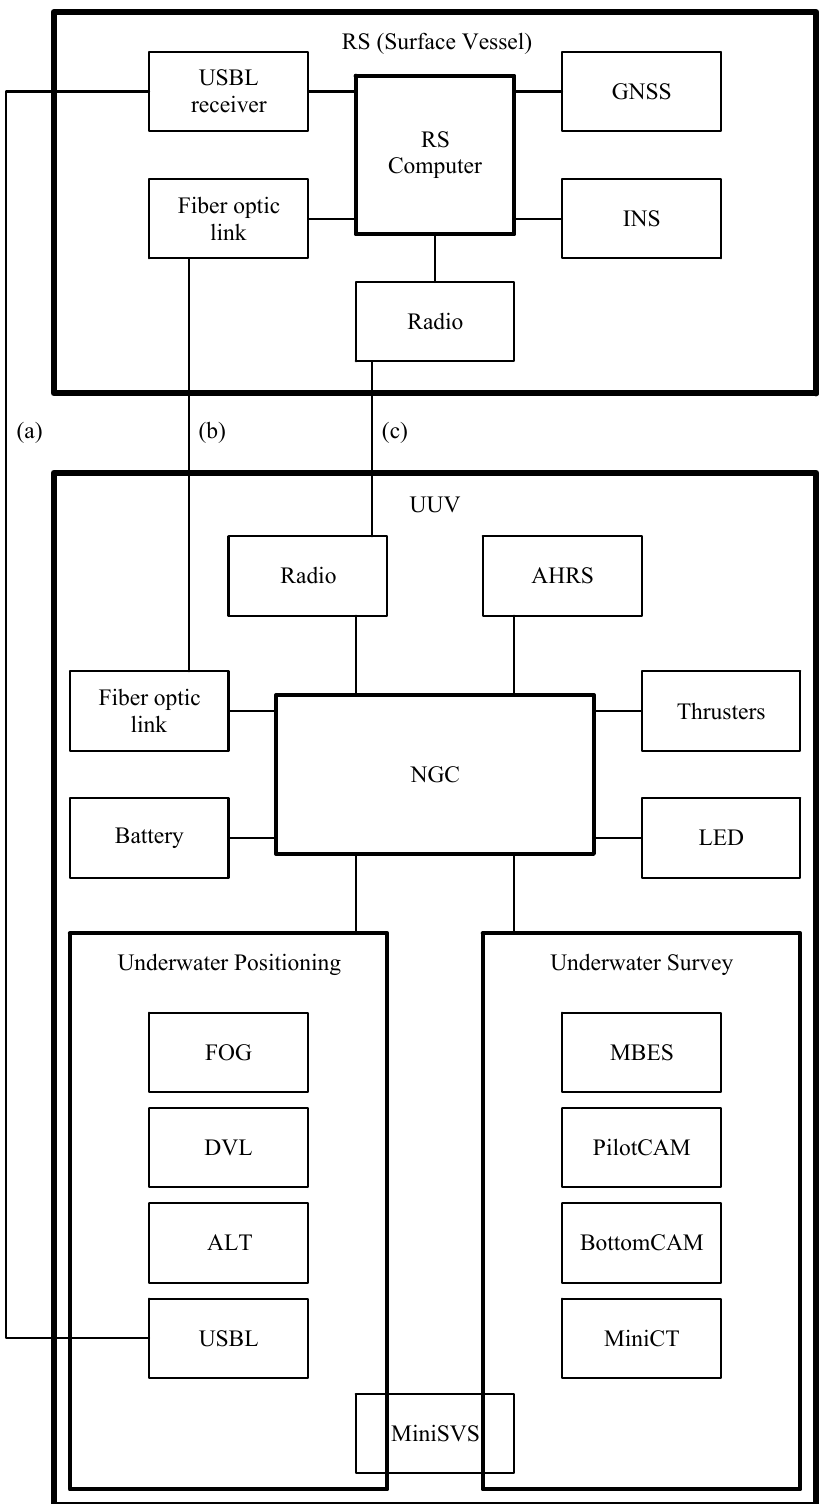
Figure 5. UUV main functional architecture and connections: ( a ) Acoustic USBL channel for AUV underwater navigation. ( b ) Fiber optic cable for ROV mode. ( c ) Radio link for AUV surface navigation and data